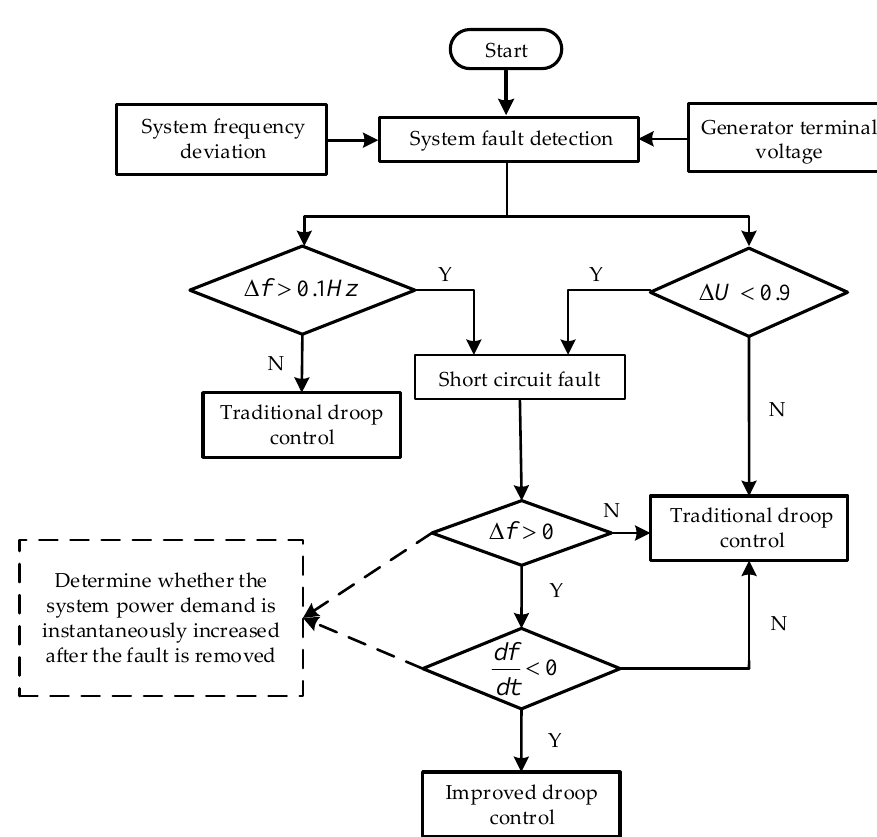
Figure 3. Improved additional frequency control.